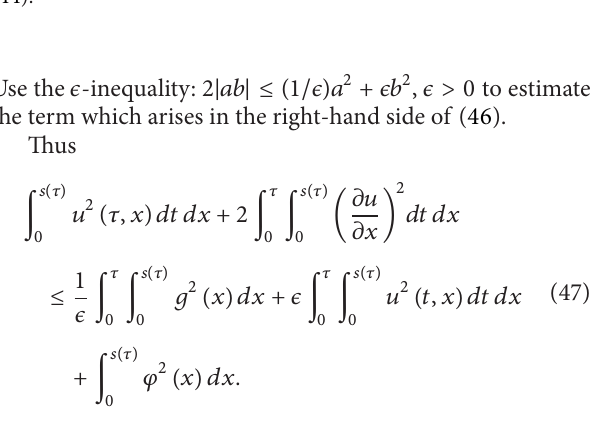
Figure3:Movingboundaryposition 𝑠(𝑡) intermsof 𝑡 obtainedfrom (44).